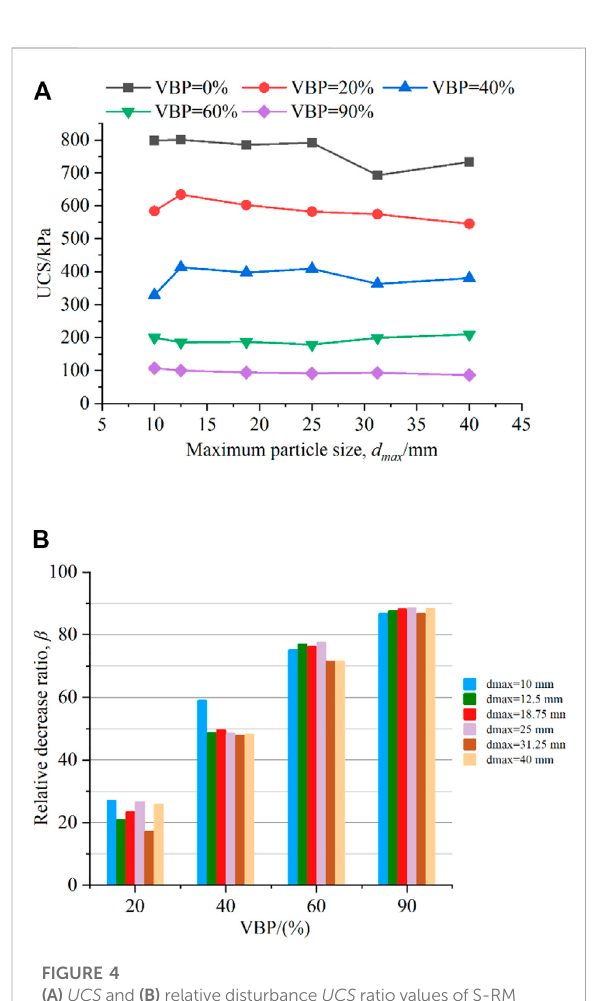
FIGURE 4 (A) UCS and (B) relative disturbance UCS ratio values of S-RM samples with different d max